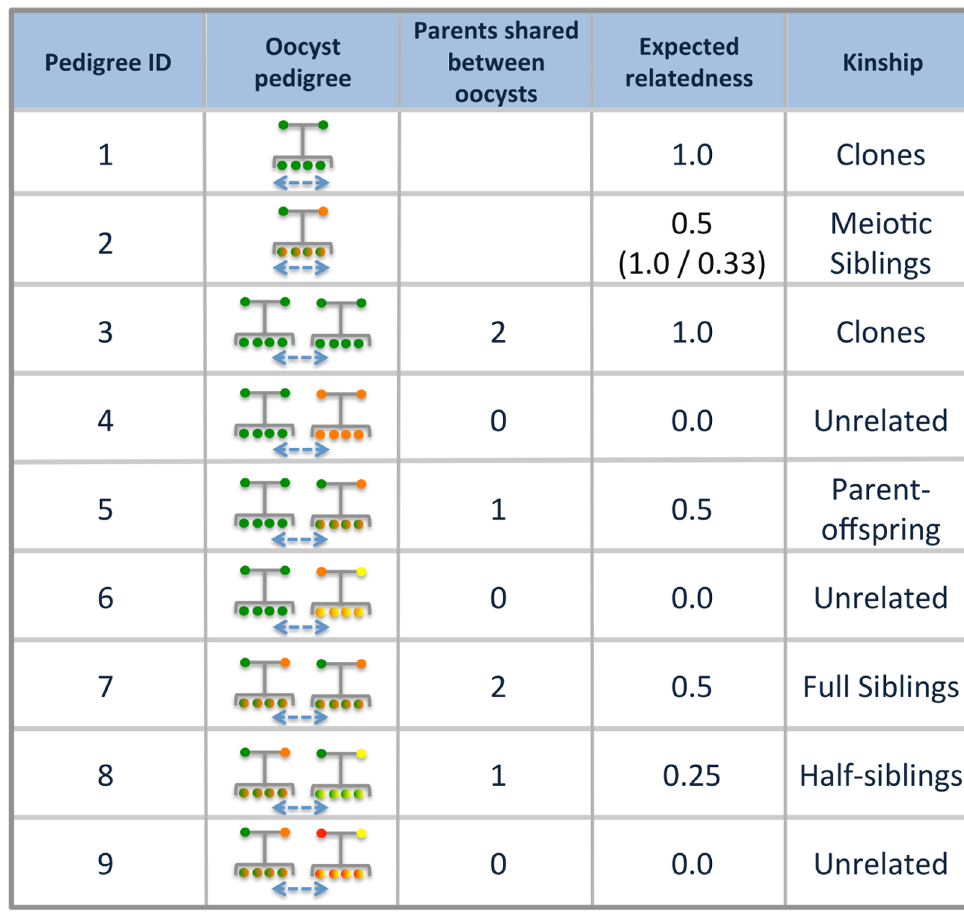
Fig 2. Pedigrees between parasites and their expected relatedness. The 9 possible pedigrees describing parasite pairs. Pedigrees represent the genetic ancestry of parasites and the oocysts they are sampled from. Circles at the top of each pedigree represent the gametes that fuse and undergo meiosis while circles at the bottom represent the sporozoites that are generated following meiosis and expansion in the oocyst. Different colors represent different genomes. Sporozoites with mixed colors indicate they are the result of outcrossing. Blue arrows between pedigrees indicate that sporozoites are sampled from different oocysts. Parasites can be sampled from the same oocyst (pedigrees 1 and 2) or from multiple oocysts (pedigrees 3–9). For pedigree 2, the distribution of expected relatedness was bimodal, and we provide the average across the entire distribution (top) as well as the two modes (bottom). Pedigree 6 and 8 are only accessible when COI (cid:21) 3 and pedigree 9 is only accessible when COI (cid:21)